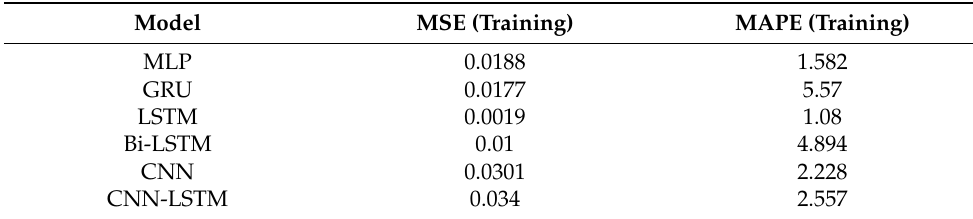
Table 3. The model’s training results using Apple data with six input features.